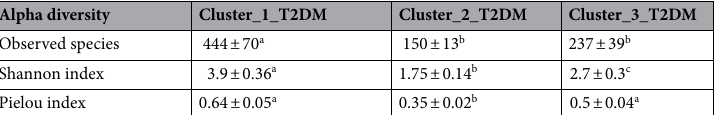
Table 1. Comparisons of observed species (richness), Shannon index (both richness and evenness) and Pielou index (evenness) in the three clusters of T2DM microbiomes, i.e., Cluster_1_T2DM, Cluster_2_T2DM and Cluster_3_T2DM. Results were represented in mean ± S.E., and the groups with different alphabets represented significant difference between the clustered T2DM